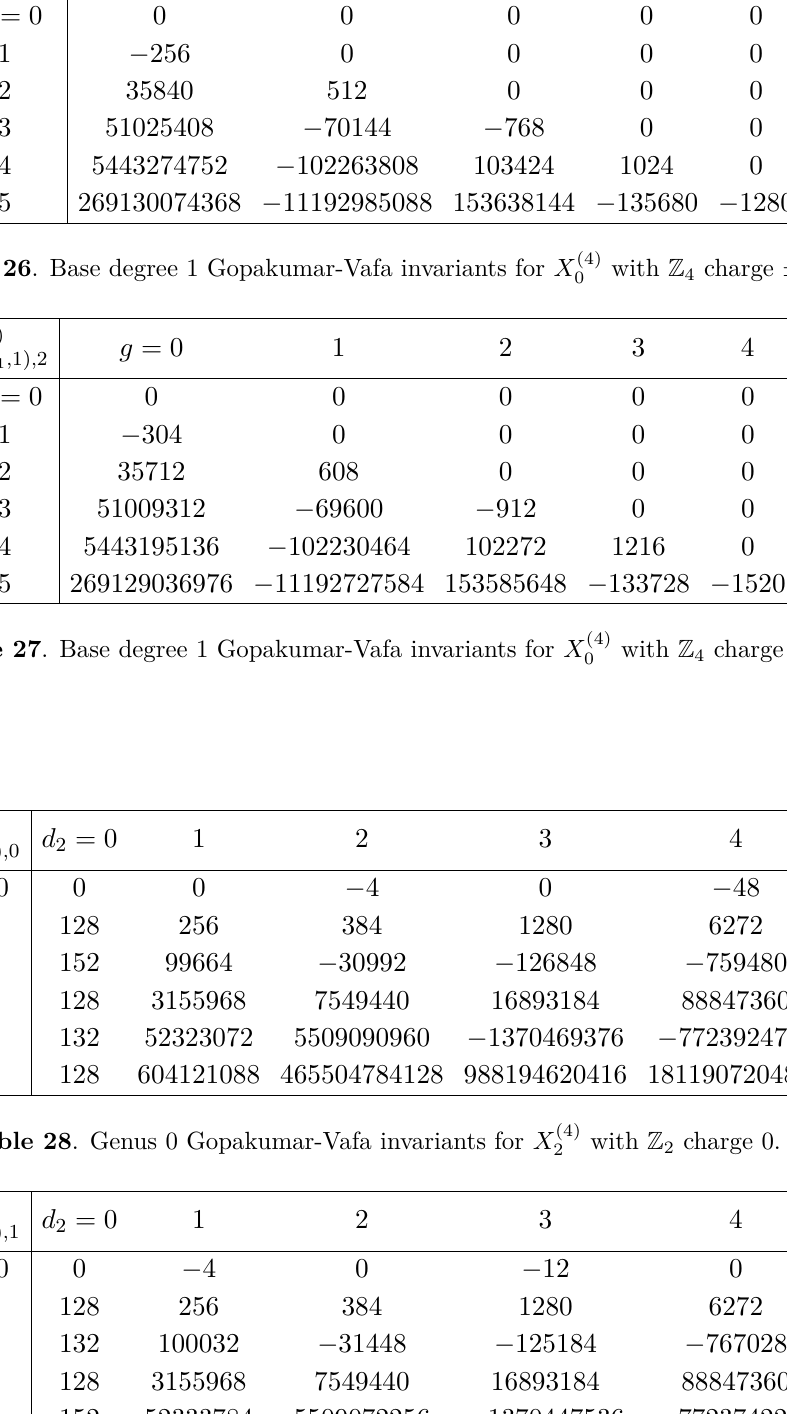
Table 29 . Genus 0 Gopakumar-Vafa invariants for X (4)